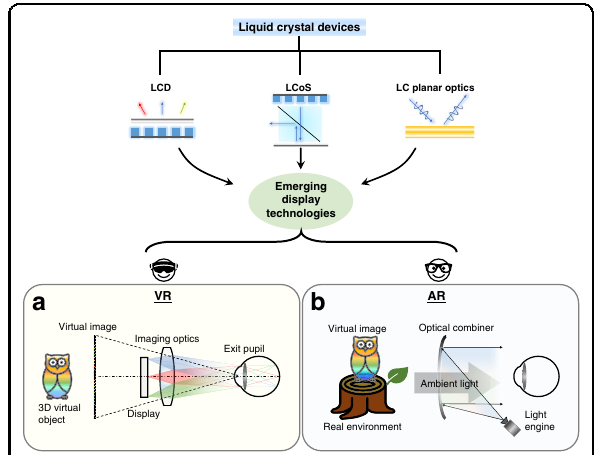
Fig. 1 Schematic of advanced LC devices applied in AR/VR systems. Top fi gure illustrates advanced LC-based devices, including LCD, LCoS, and LC planar optics. These LC devices contribute to novel display technologies, including AR and VR systems. The bottom fi gure shows the system con fi gurations of a VR and b